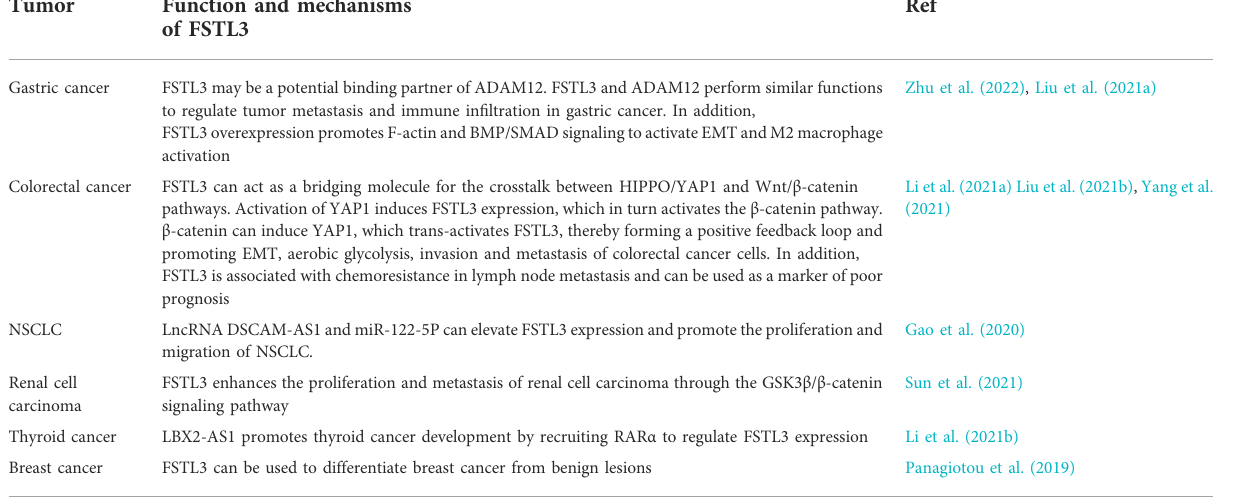
TABLE 2 Function of FSTL3 in different types of cancer. Tumor Function and mechanisms of